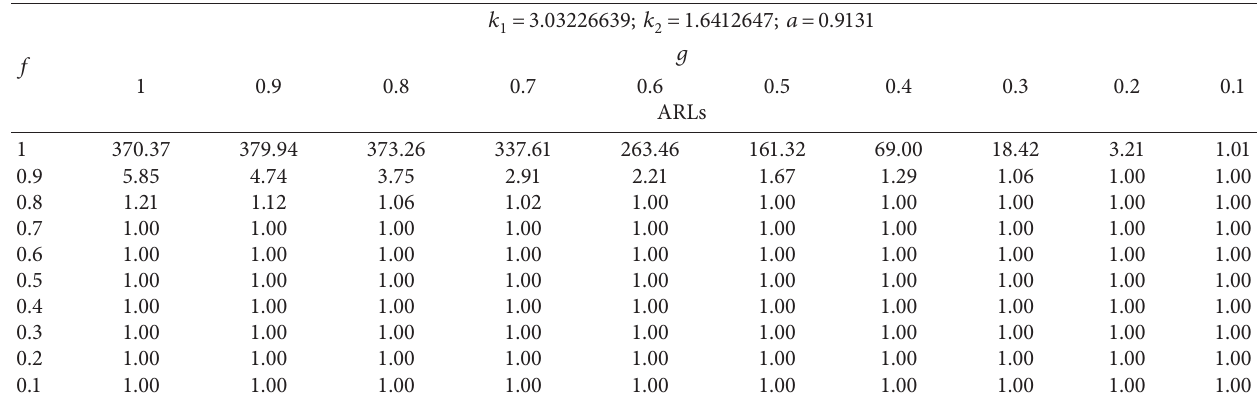
Table 3: The values of ARLs when b � 0.31, n � 30, and i � 4.